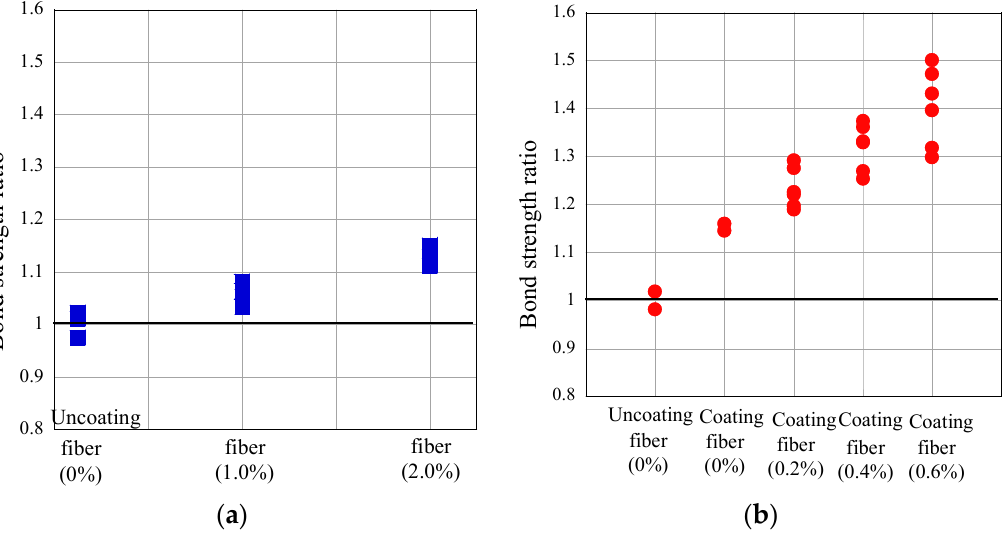
Figure 9. Comparison of the bond strength ratios: ( a ) uncoated rebars [32]; ( b ) UHPC-coated rebars.